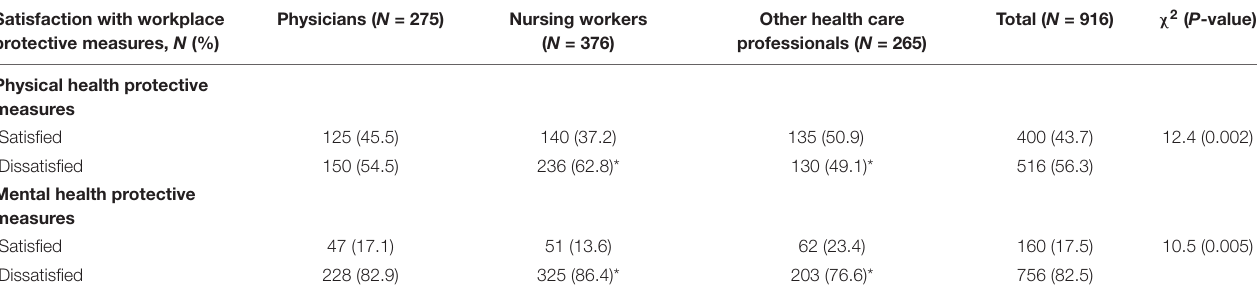
TABLE 2 | Health care professionals’ reports of satisfaction with their workplace measures to protect their physical and mental health during the COVID-19 pandemic.